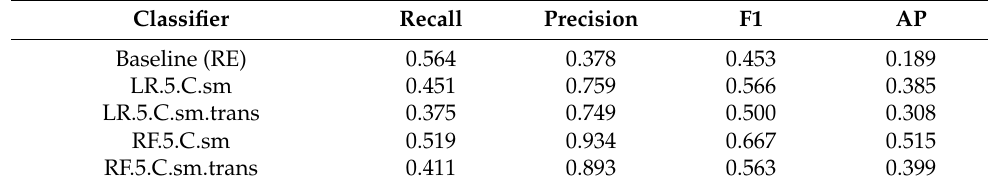
Table 6. Classifier performance for the 5.sm.C dataset and different feature sets.